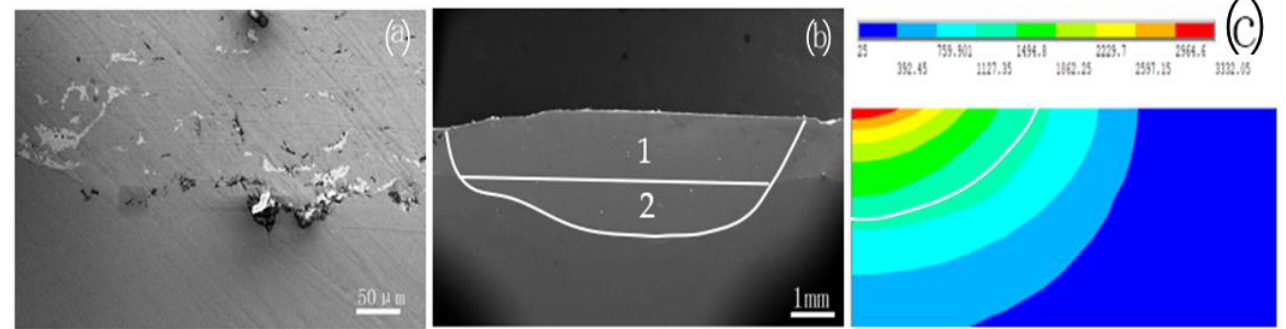
Figure 9. Before and after cladding and the cross section of the simulated molten pool. ( a ) Before cladding; ( b ) After clad- ding; ( c ) Cladding simulation.